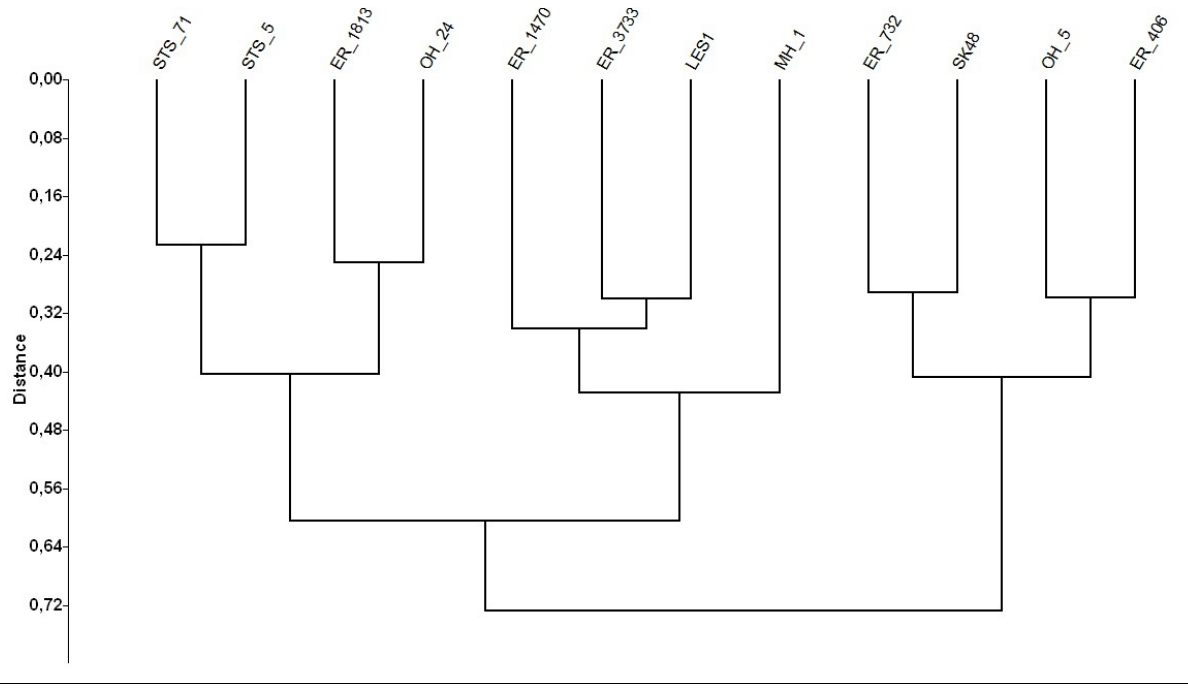
Scientific Correspondence https://doi.org/10.17159/sajs.2022/11913